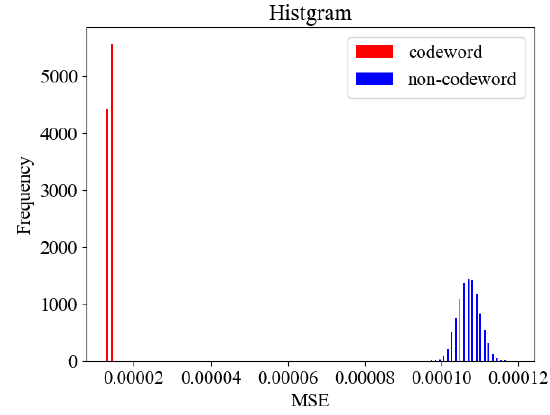
Figure 5. Histogram of MSEs of codeword and